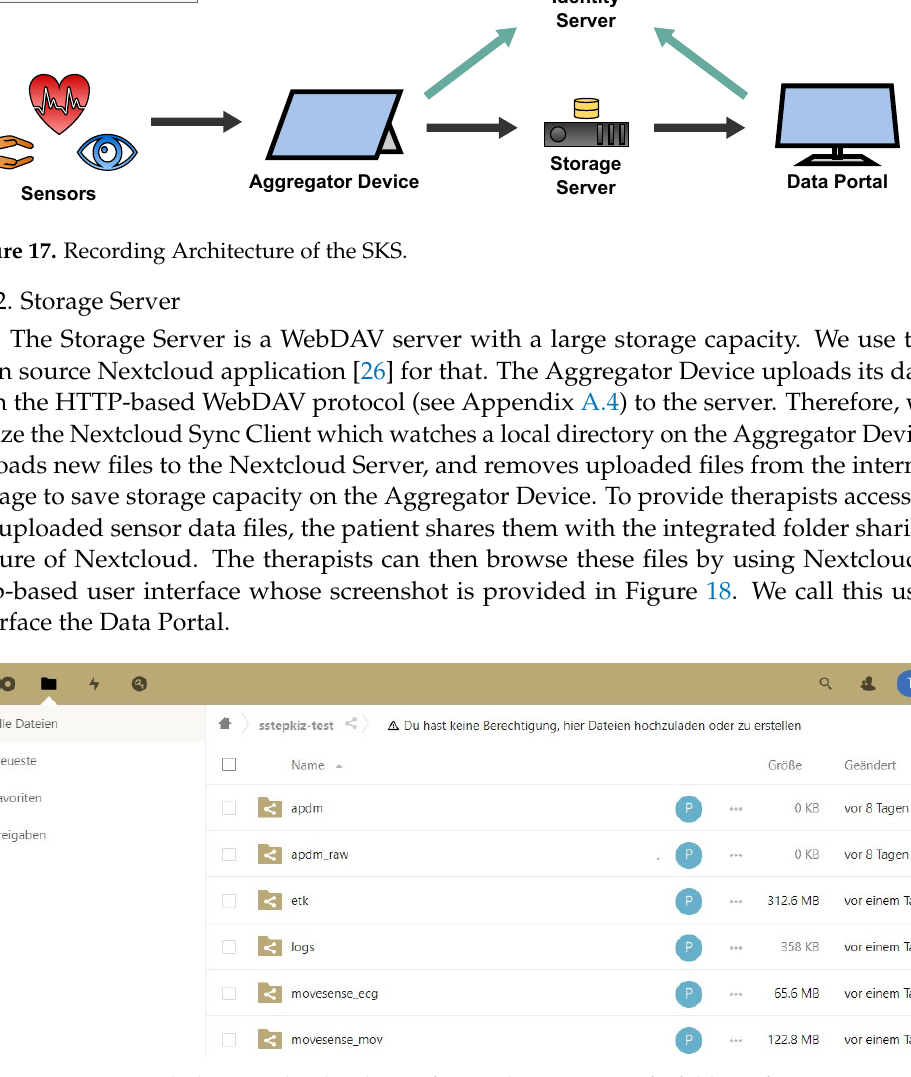
Figure 18. Data Portal: the Nextcloud web interface with sensor-specific folders of a